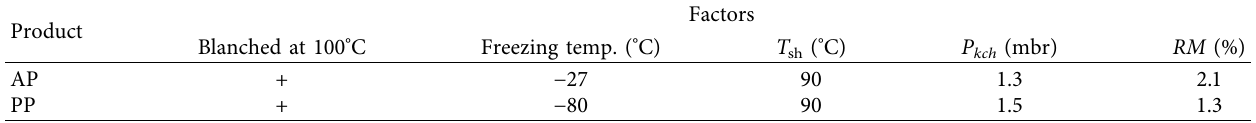
Table 1: Different optimized conditions in freeze-dryer.